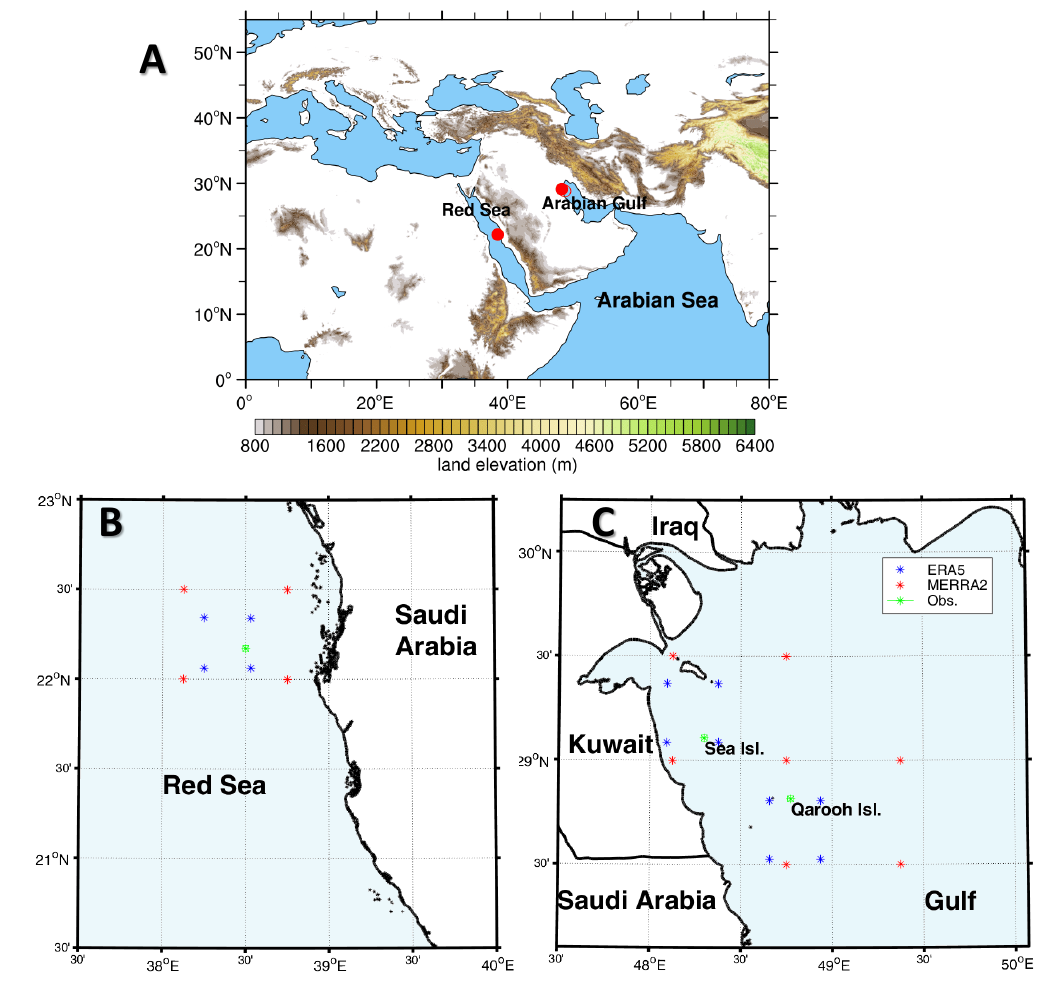
Figure 1. ( A ) Land elevation above 800 m from the ETOPO2 Global Relief data [26]. Red dots indicate the WHOI/KAUST buoy site in the northern Red Sea and the KMO buoy in the Arabian Gulf. Open circle is the Qarooh Island meteorological station. Maps ( B , C ) show the reanalysis products (ERA5 in blue and MERRA2 in red) and observation stations (green) used in this